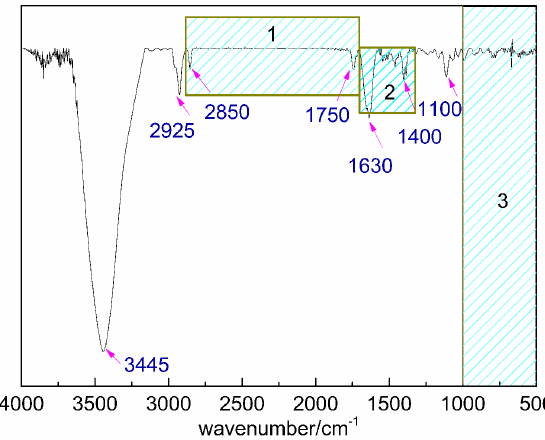
Figure 6: The FT-IR curve of coal-based electrode material.